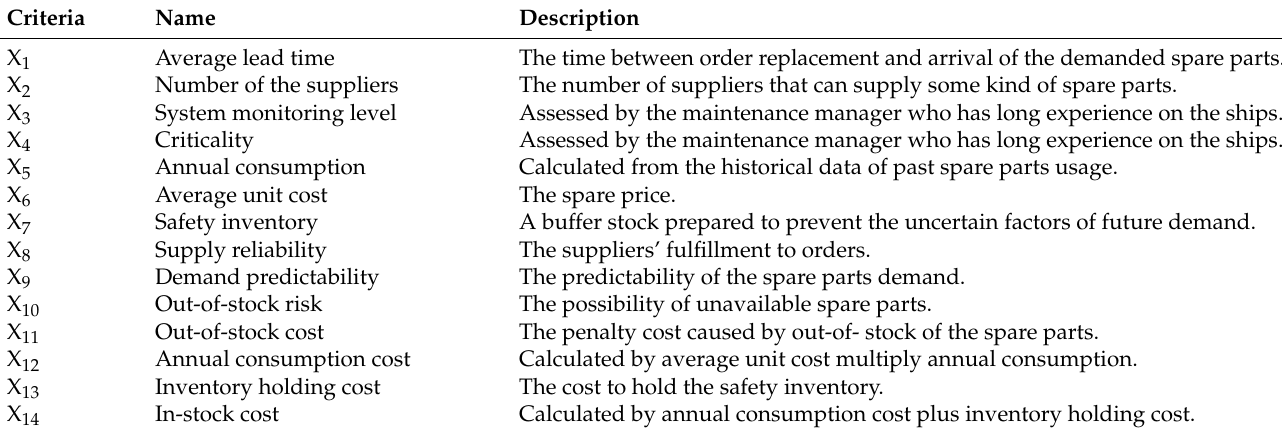
Table 1. Multiple spare parts classification